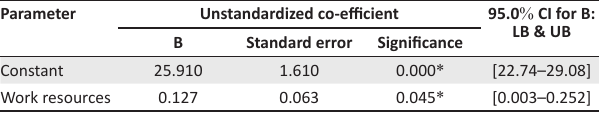
TABLE 4: Parameter estimates for work resources on employee physical